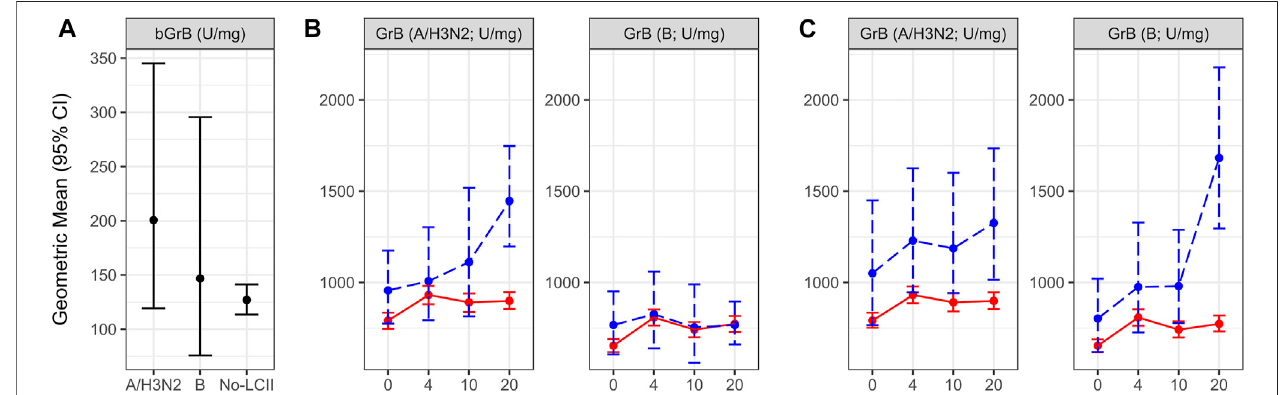
FIGURE 2 | Change over the study period for granzyme B activity (GrB) in PBMCs, and for basal GrB activity (bGrB) strati fi ed by laboratory-con fi rmed in fl uenza illness (LCII) status at 4 – 20 weeks post-vaccination compared to the Null (No-LCII) subset. (A): The geometric mean and 95% CI for bGrB is presented for each LCII status category GrB activity in response to ex vivo stimulation with (B): A/Victoria (left) or B/Lee (right) virus in H3N2 LCII vs Null subsets and (C): A/Victoria (left) or B/ Lee (right) virusinB-LCIIvsNullsubsets.GrBactivitylevelsatpre-vaccination (0weeks)and4,10and20-weekspost-vaccinationarepresentedasthegeometric mean and 95% con fi dence interval. For both B and C , participants without documented LCII are indicated by red, solid lines (n (cid:1) 582); blue, dashed lines indicate participants with A/H3N2 (n (cid:1) 18; panel B ), and B LCII (n (cid:1) 9; panel C ).